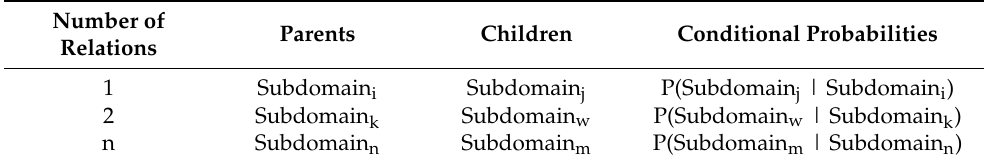
Table 9. Relation Direction Probability (RDP).